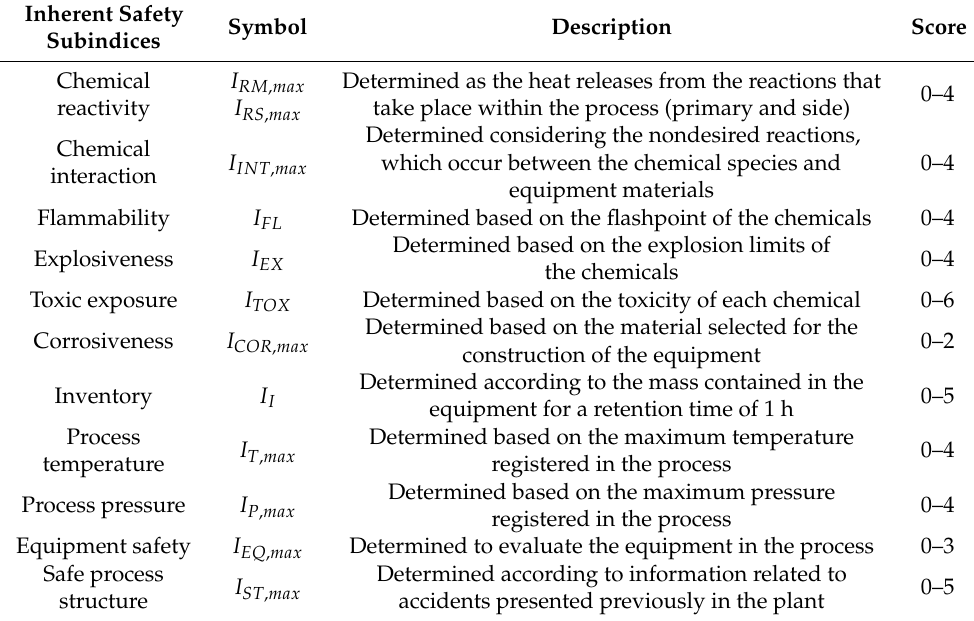
Table 2. Symbols and description for inherent safety subindices, adapted from